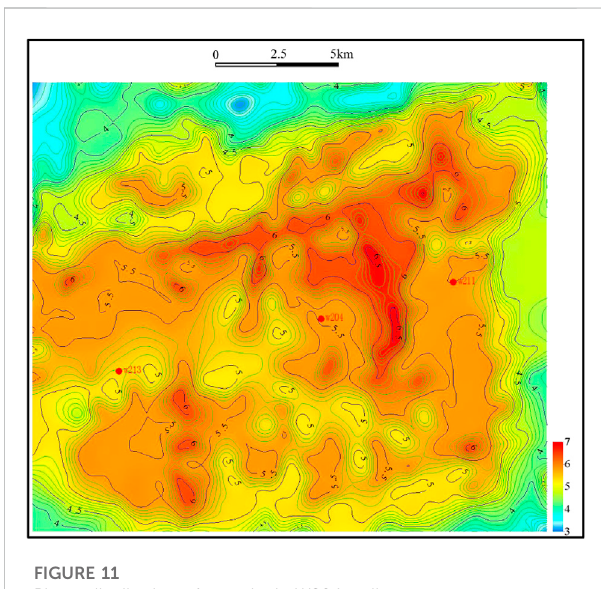
FIGURE 11 Planar distribution of porosity in W204 well area.